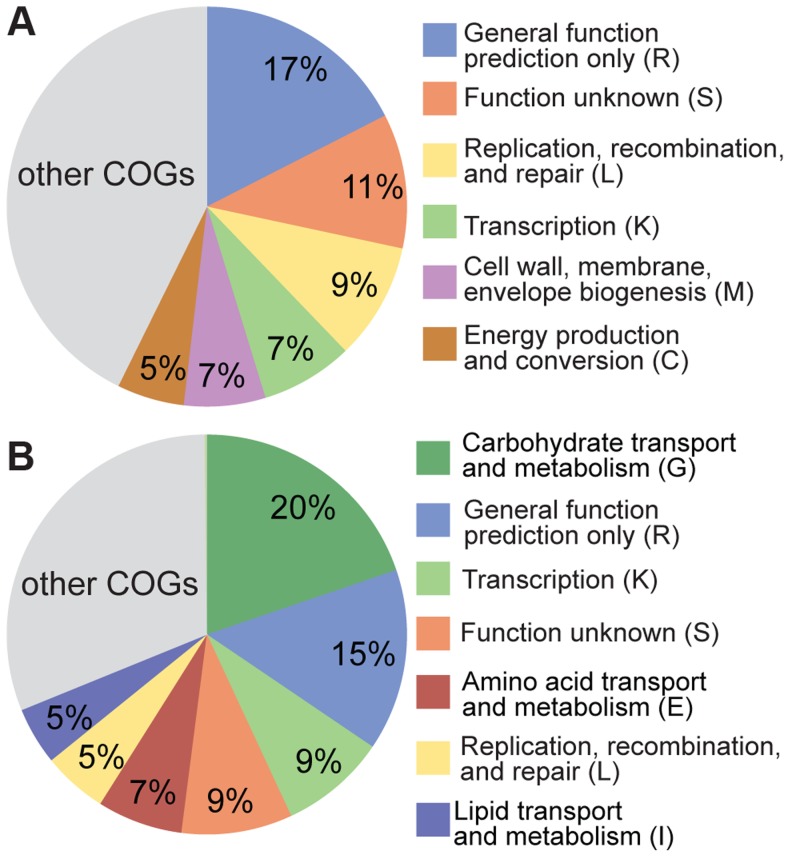
Functional classification of the accessory genes of (A) S. alvi SAGs and (B) G. apicola SAGs based on COG categories.303 of 755 accessory genes of S. alvi SAGs and 476 of 851 accessory genes of G. apicola SAGs could be classified into COGs. Categories covering ≥5% of the classified accessory genes are shown. Minor categories (<5%) are summarized in the grey colored area of the pie charts. Categories R, S, and L include genes associated with mobile genetic elements.